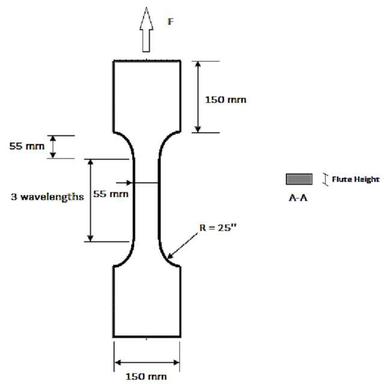
Transverse tensile test on corrugated board with sample dimensions.